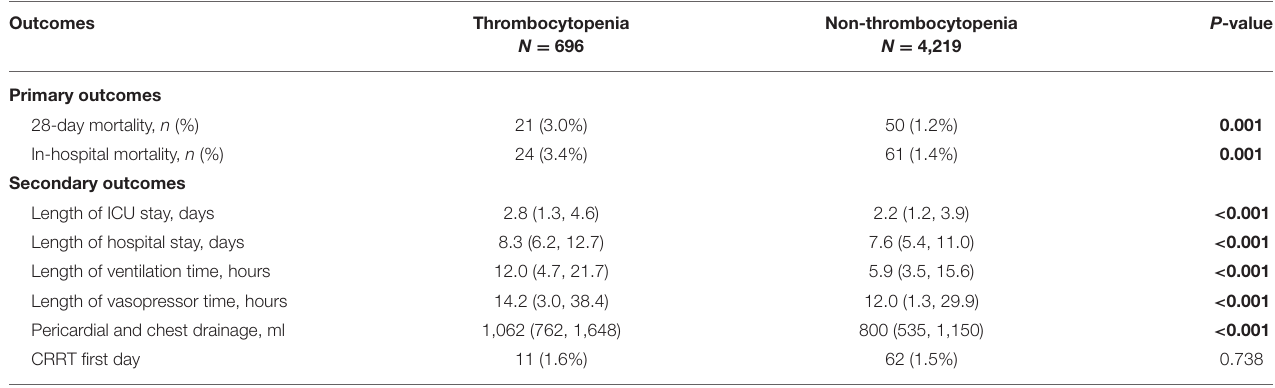
TABLE 3 | Clinical outcomes between study cohorts.